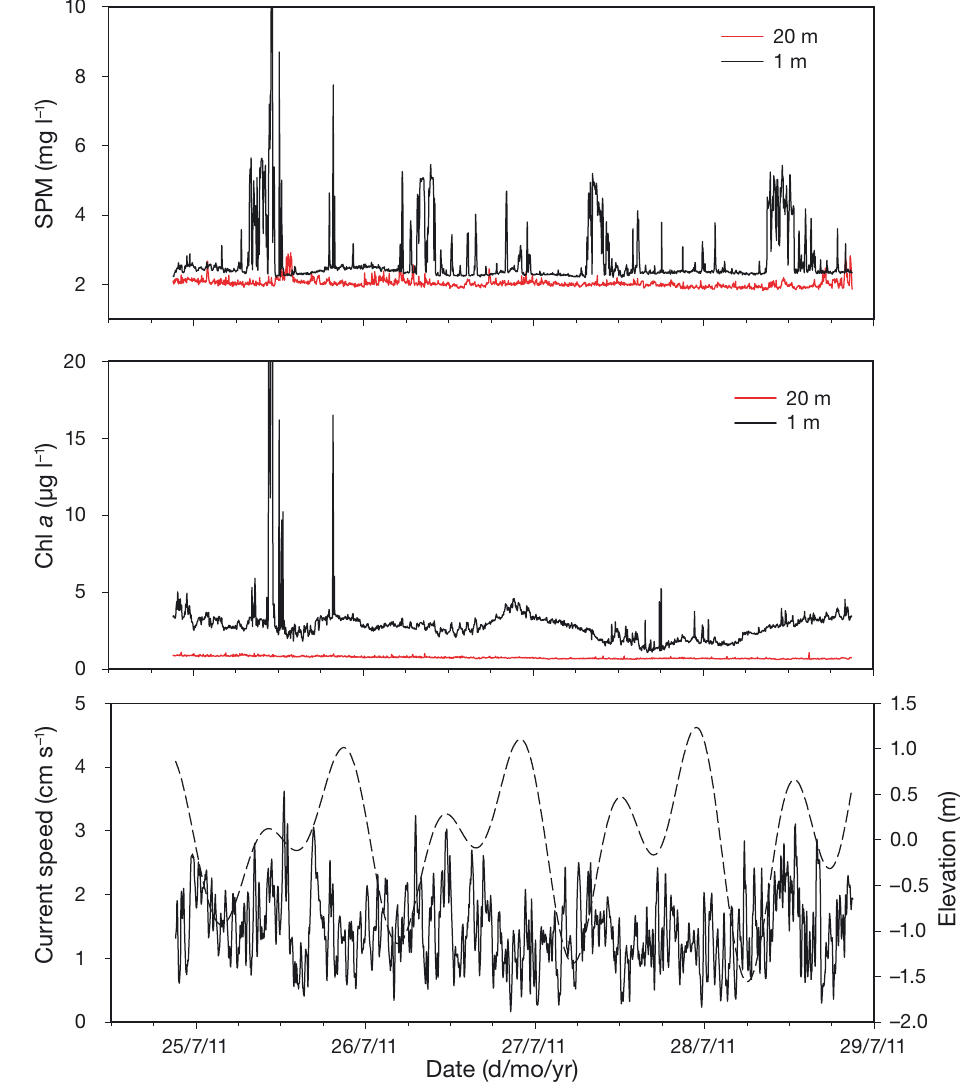
Fig. 4. Suspended particulate matter (SPM) and chlorophyll a (chl a ) concentrations and current speeds, collected at 1 min in- tervals, at the Kyuquot Sound black cod farm. Data are from 1 and 20 m depths (19 m for current speed) at a mooring located 1 m from a net-pen (Fig. 1). The dashed line is the predicted tidal